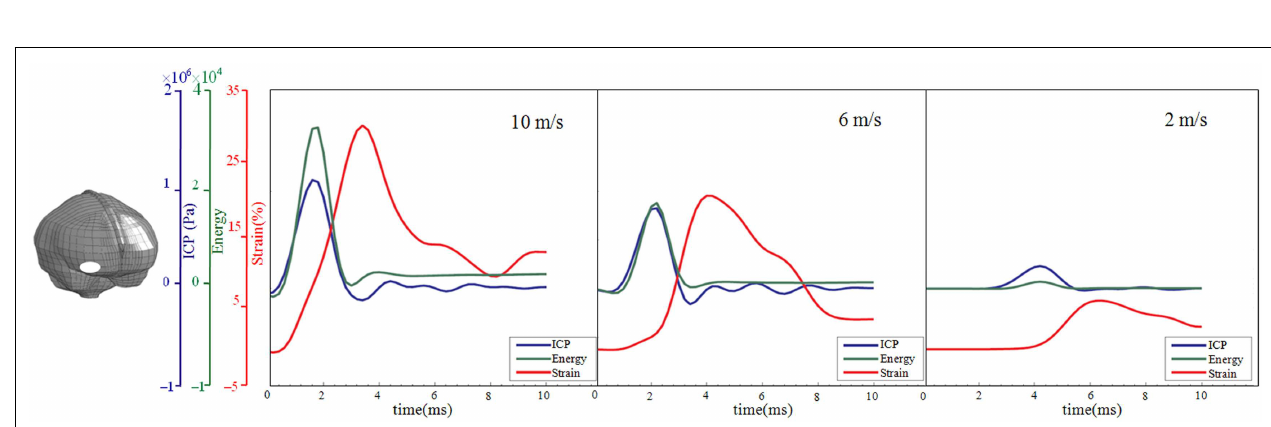
FIGURE 4 | Representative coronal slice of ICP and first principal strain captured at different time points during the impact for velocity of 10m/s (two upper rows), 6m/s (two middle rows), and 2m/s (two lower rows).